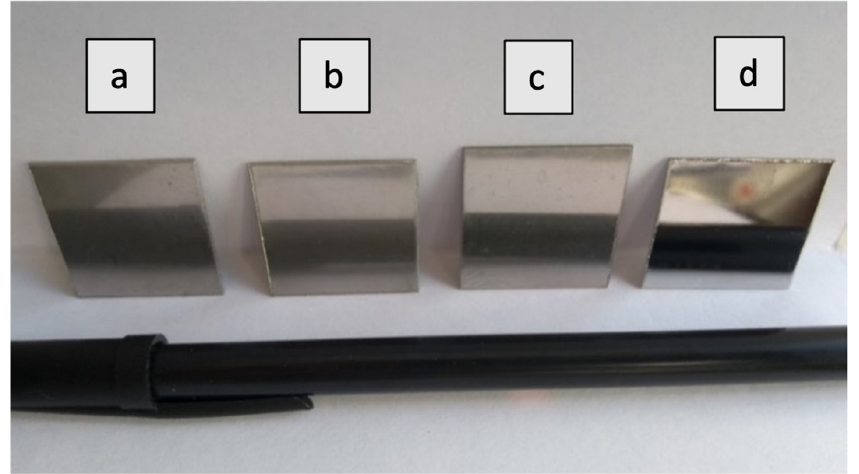
Figure 3. Substrates according to treatment: NT-No treatment ( a ), DC-Detergent cleaning ( b ), AT-Acid treatment ( c ), EP-Electropolishing ( d ).